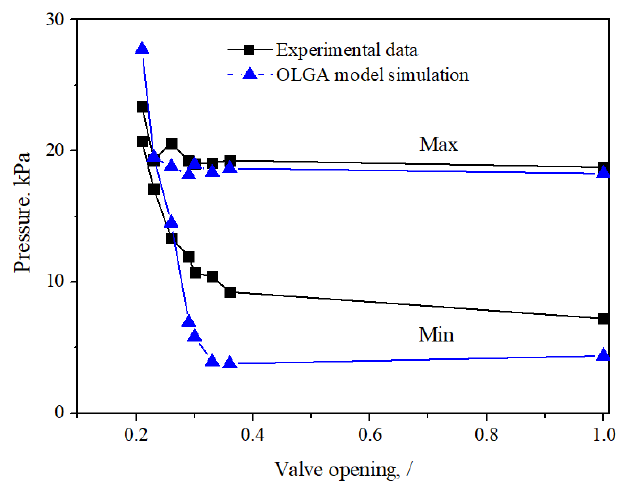
Figure 15. Comparison of measured and simulated riser-base pressure bifurcation map.